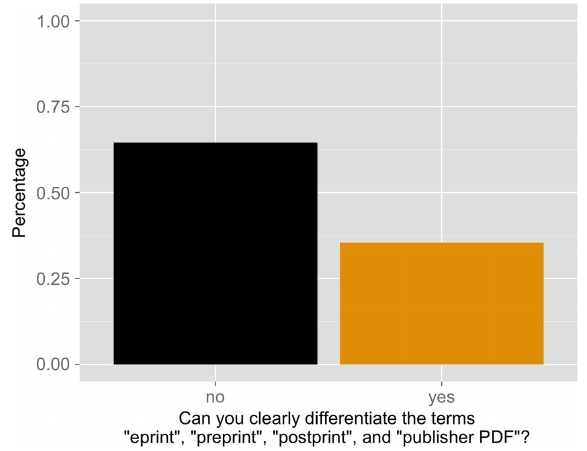
Figure 2. Answers to the question: Can you clearly